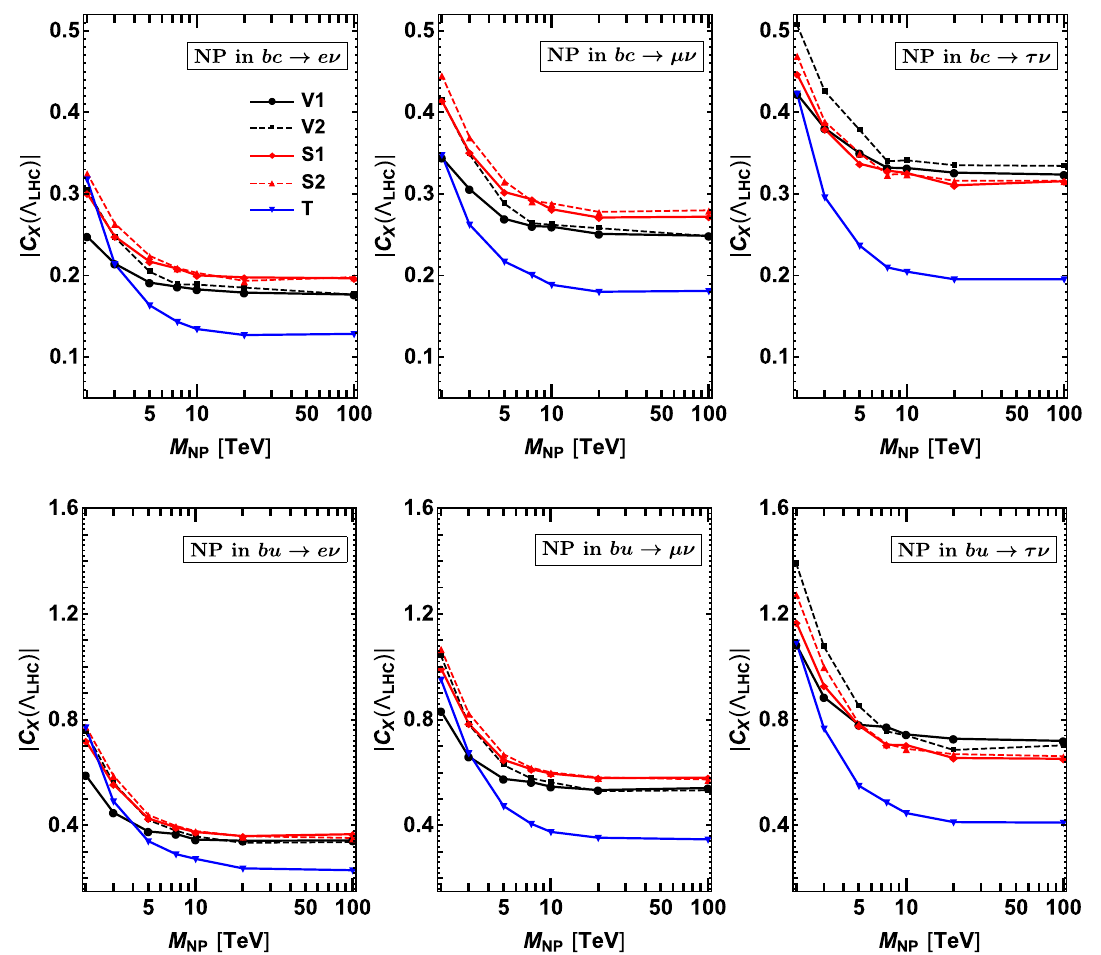
(Λ ) obtained from the (cid:6)ν and τν search data by ATLAS [17] and CMS [9], respectively, where we LHC X